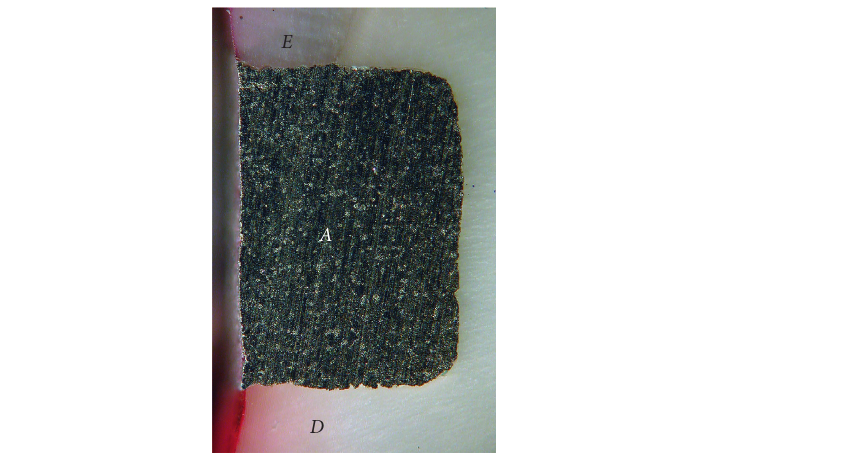
Figure 1: Leakage-free margin of amalgam bonded with Super-Bond D-Liner II Plus soaked in the artificial saliva, a negative control (original × 50, E � enamel, D � dentin, and A � amalgam).